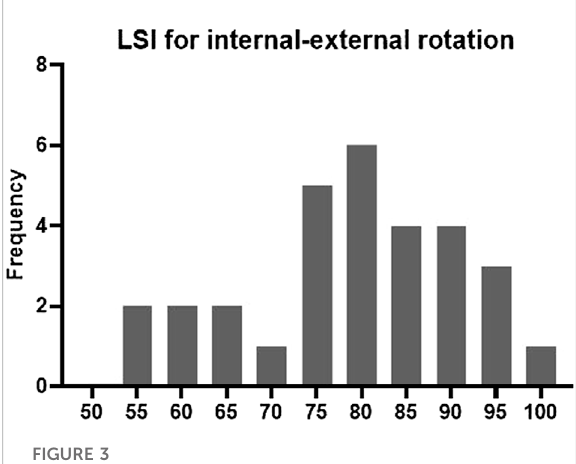
FIGURE 3 Frequency distribution of internal-external rotation